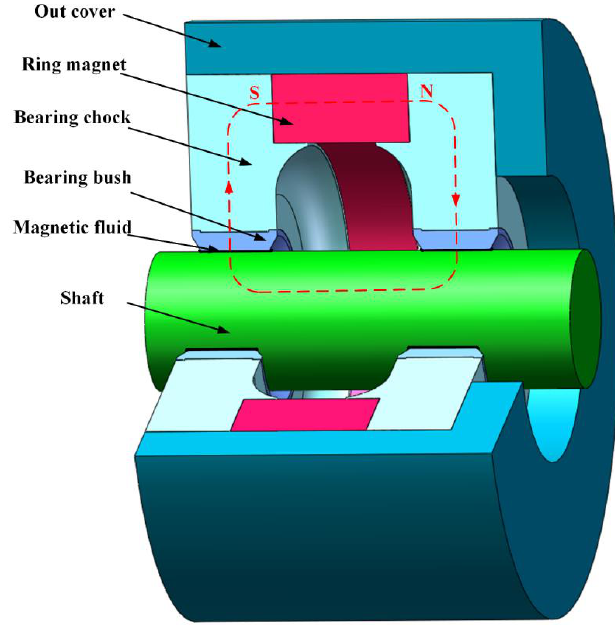
Table 2. Basic parameters of permanent magnet rings.